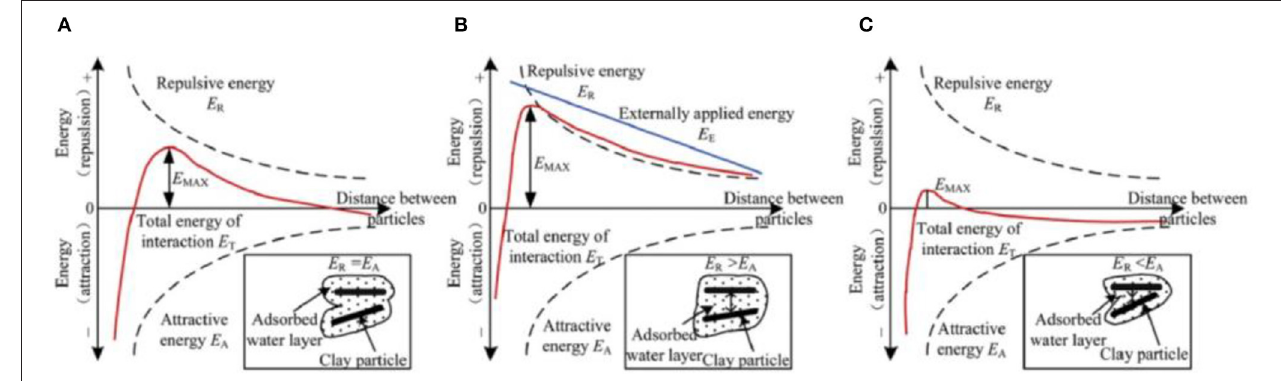
FIGURE 4 | Energy–distance curves for thixotropic soil [modified from Mitchell (1961)]: (A) at initial, undisturbed configuration, E R = E A , flocculation structure, (B) during remolding, E R > E A , repulsive energy barrier prevents flocculation, and (C) at rest in the thixotropy, E R < E A , particles attempt to flocculate.